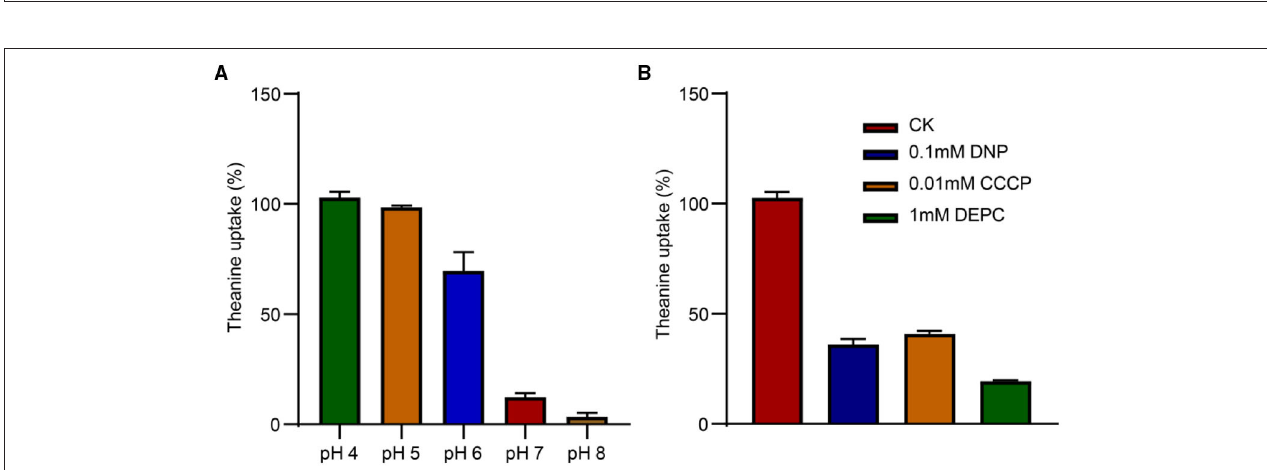
FIGURE 5 | The pH dependence of CsCAT2 uptake of theanine in 22 1 10 α . (A) Theanine uptake by CsCAT2 at different pH values; uptake at pH 4 serve as 100%. (B) Theanine uptake by CsCAT2 in the presence of CCCP, DNP, and DEPC. The result was expressed as mean ± SD ( n = 3).